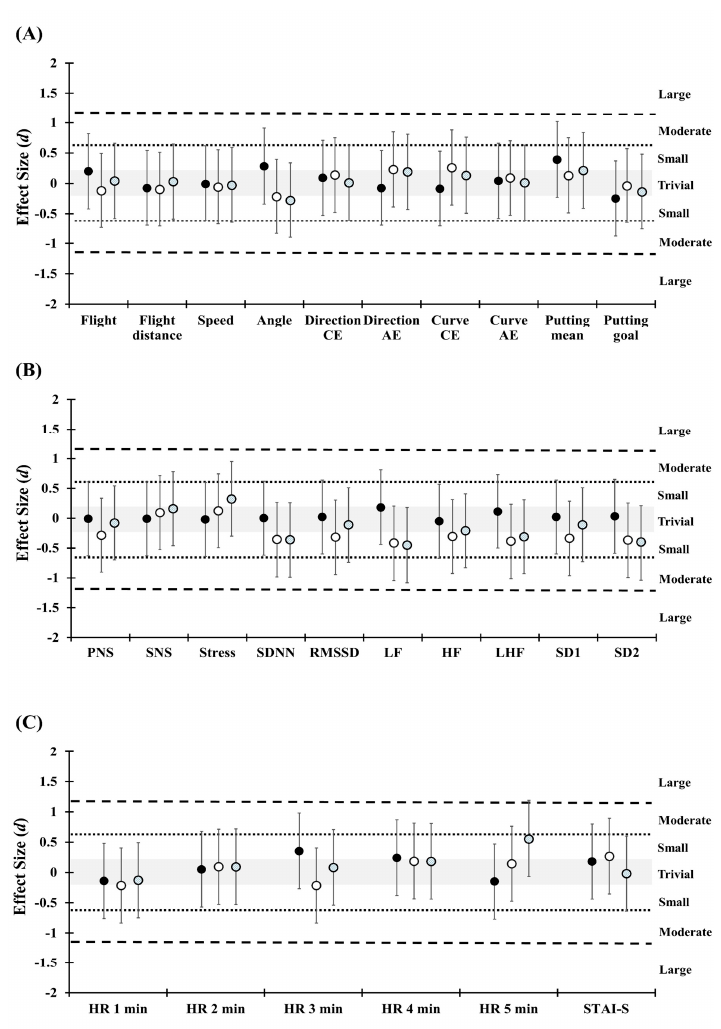
Figure 3. Standardized di ff erences (e ff ect size) of the golf swing, golf putting, heart rate variability, heart rate, and state-trait anxiety inventory-state questionnaire between phase one and phase two measurements. ( A ) notes the e ff ect size in golf swing and putting performance; ( B ) notes the e ff ect size in heart rate variability variables; ( C ) notes the e ff ect size in heart rate responses and anxiety level. The positive values of e ff ect size indicate A value greater than B value and vice versa. Grey area represents trivial e ff ect size. The black full circle indicates phase one and phase two comparison in non-music trial. The open circle indicates phase one and phase two comparison in pre-exercise music trial. The grey circle indicates phase one and phase two comparison in simultaneous music trial. CE = constant errors; AE = absolute errors; PNS = parasympathetic nervous system index; SNS = sympathetic nervous system index; SDNN = standard deviation of normal R-R interval; RMSSD = root mean square of successive RR interval di ff erences; LF = low frequency power spectrum; HF = high frequency power spectrum; LHF = low frequency and high frequency ratio; SD1 = the standard deviation of the points perpendicular to the line of symmetry; SD2 = the standard deviation of the points along the line of symmetry; HR = heart rate; STAI-S = state-trait anxiety inventory-state